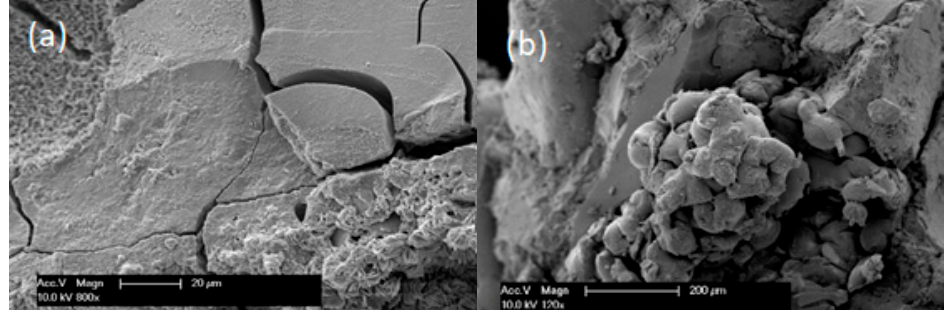
9 of 14 Figure 8. Expansion according to Procedure 3 (38 °C and R.H. 100%). The following observations can be drawn: (i) in all the investigated conditions, ex- pansion significantly depended on the w/c ratio; (ii) the differences were not negligible when considering that the expansion limit (0.1% in ASTM C1296, as an example) that characterized potentially reactive aggregates was rather low; and (iii) there were no re- markable differences between the expansion of the 2A and 2B 7-day samples, despite the fact that alkalis were already present in the bulk of the 2A mortars. Thus, the rate of ex- pansion in both Type 2 procedures seemed to be almost independent of the rate of diffu- sion of Na + ions, as other researchers [31] using similar conditions have already under- lined. In all investigated conditions, the air-entraining additive acted as an extremely effi- cient means of preventing the expansion of the samples, thus completely masking the al-